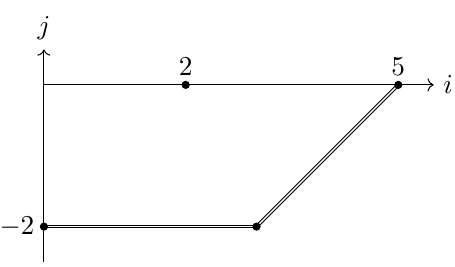
Figure 1 . The Newton diagram ∆( F ) of the polynomial (4.15) consists of the four solid dots shown in this figure. The corresponding Newton polygon, the lower convex hull of the Newton diagram, is labelled by double lines. The vertical axis labels the powers of ˆ φ while the horizontal axis labels the powers of s